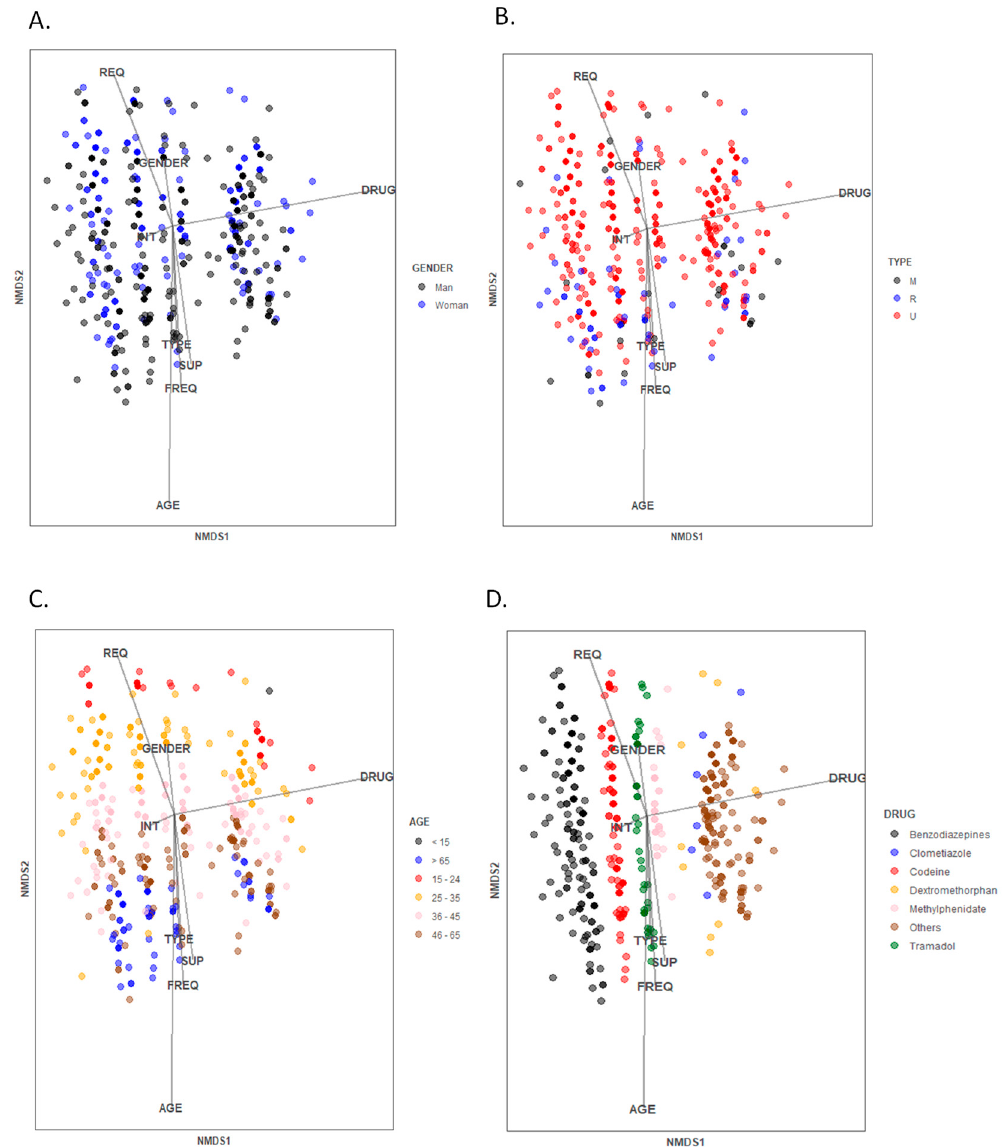
Figure 5. Distribution of the studied population analysed by non-metric multidimensional scaling (NMDS). Different influencing characteristics of the participants are depicted in colours: ( A ) gender, ( B ) type of pharmacy, ( C ) age and ( D ) type of drug requested. The vectors correspond to the variables analysed together: GENDER, DRUG, TYPE (type of pharmacy), SUP (whether the drug is supplied or not), INT (request with intimidation), FREQ (frequency demanding the drug) and AGE. The analysis includes the 548 notifications. It can be observed the clustering of the users depending on the stablished parameters being the age and type of drug the clearest influent